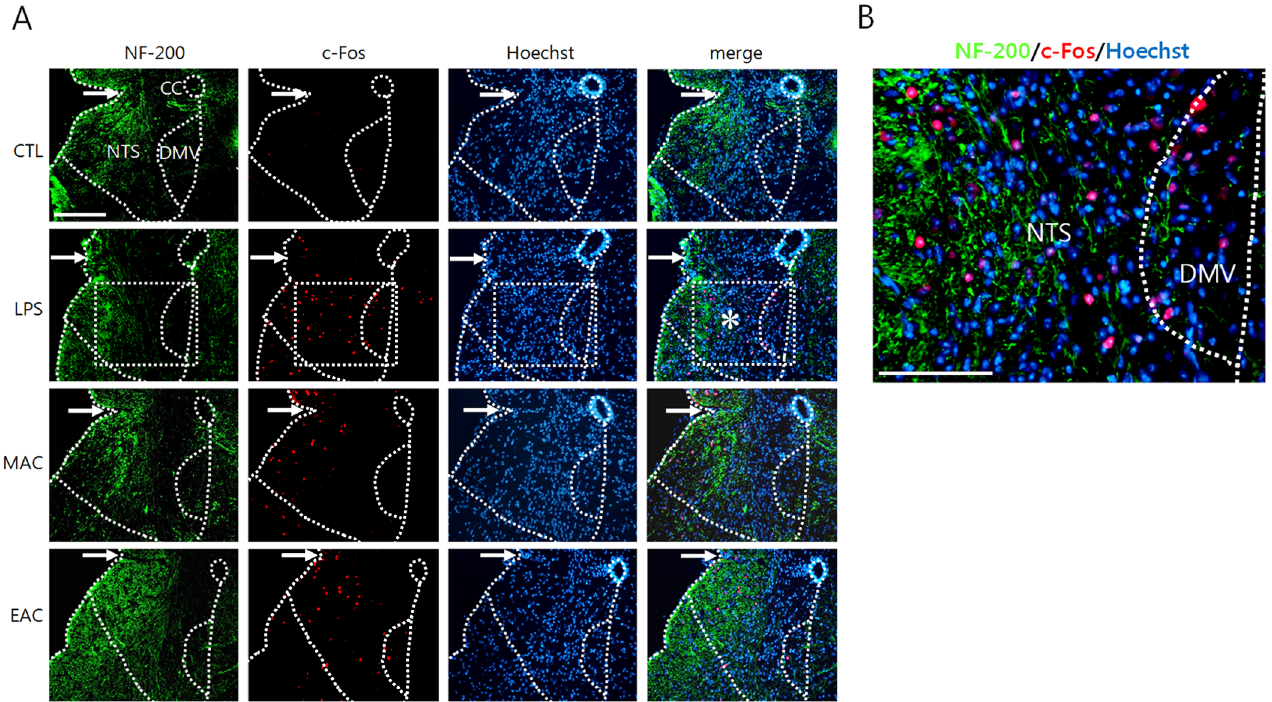
Fig 3. c-Fos induction in the DVC by AS and LPS administration. Following LPS injection (180 min later) or AS (90 min later), transverse sections through the caudal portion of the brainstem were used for immunofluorescence staining for NF-200 (green) and c-Fos (red) with Hoechst nuclear counterstaining (blue). An enlarged view (B) of the rectangular area in (asterisk in A) clearly reveals c-fos signals. Arrows in (A) denote the approximate NTS boundary between two hemispheres. cc: central canal. The scale bars in (A) and (B) are 100 μ